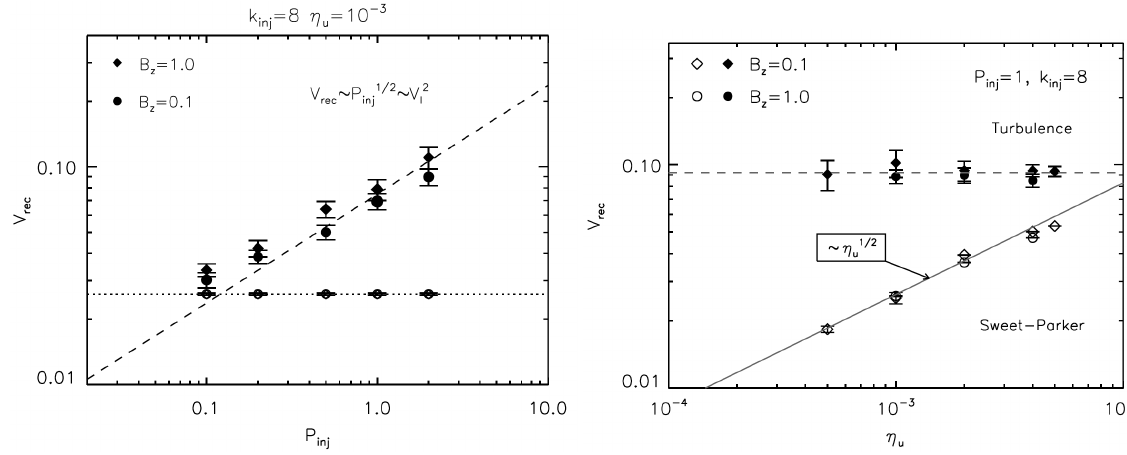
Fig. 4. Left panel: dependence of the reconnection speed V R on injection power P inj . Right panel: dependence of the reconnection speed V R on the uniform resistivity η u . Open symbols are for Sweet-Parker reconnection scenario (Sweet, 1958; Parker, 1957), and filled symbols are for weakly stochastic reconnection scenario (Lazarian and Vishniac, 1999). See Kowal et al. (2009); Lazarian et al. (2011).